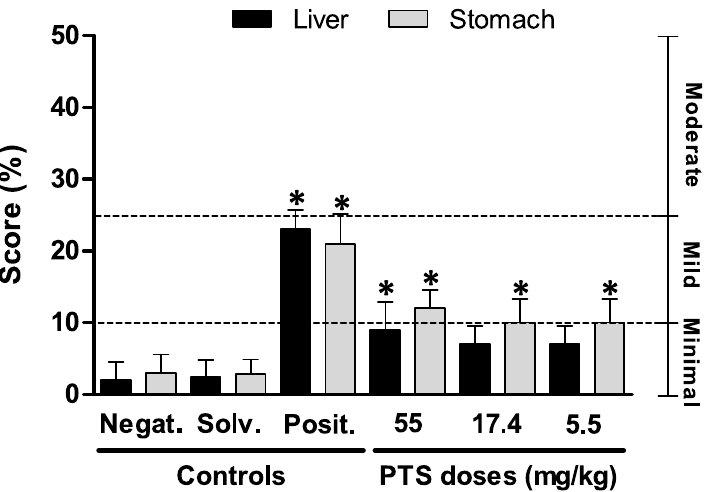
Figure 4. Mean ± standard deviation (SD) of the histopathological score recorded in the liver and stomach of female and male rats treated with PTS. * Statistical difference ( p < 0.05) compared to the negative and solvent controls using the nonparametric Kruskal–Wallis test followed by Dunn’s multiple comparison test.